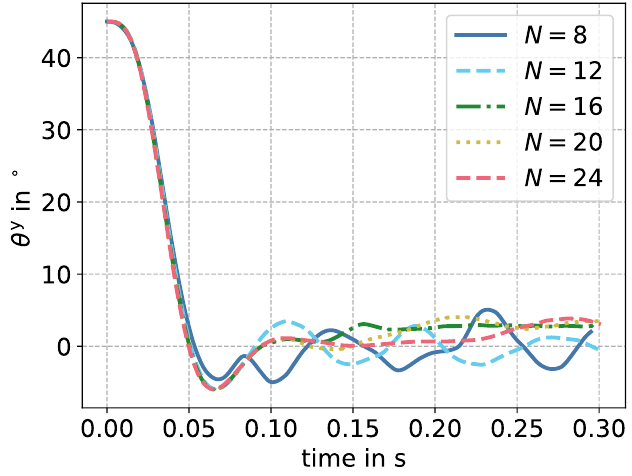
Figure 5. Plot of the angle for rotation around the y -axis over time during the settling. Results printed for different grid spacings, for the particle with the shortest half-axis.